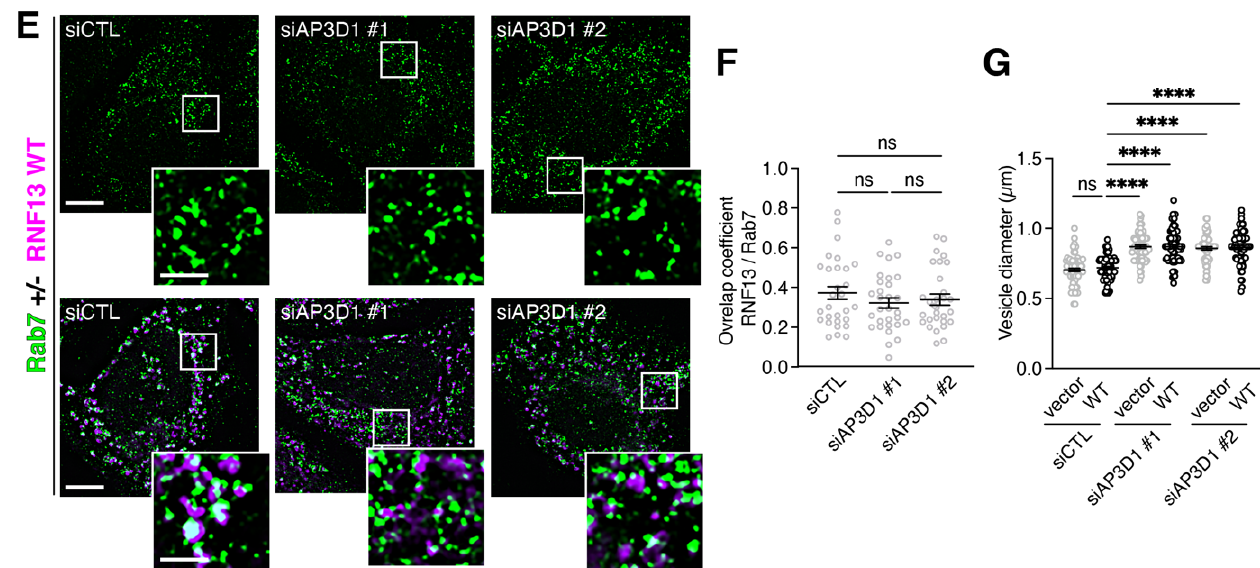
Figure 6. Knockdown of AP-3 interferes with RNF13 localization to lysosomes. ( A ) HeLa cells were transfected using 10 nM of Dicer-substrate siRNAs (DsiRNAs) specific against AP3D1 or nontargeting (siCTL). Three DsiRNAs specific against AP3D1 were tested. Seventy-two hours after transfection, cells were lysed and diluted in Laemmli buffer. Proteins were separated on SDS–PAGE and transferred to a PVDF membrane which was immunoblotted using specific primary antibody against AP3D1. Band densities were analyzed and normalized to the band density of the siCTL lane using ImageLab software. The bar graph presents the mean ± SEM while the strip plot represents the averaged relative protein abundance of each independent experiment analyzed (N = 3). Not significant (ns) or * p < 0.05 using one-way ANOVA with the Kruskal–Wallis test. ( B – G ) HeLa were transfected using 10 nM of DsiRNAs #1, #2 or siCTL for 72 h. Twenty-four hours prior to fixation, cells were transfected with either a plasmid construct encoding HA-tagged RNF13WT or an empty vector. Cells were fixed, permeabilized, and labeled with specific primary antibody against HA (RNF13) and against the endogenous subcellular markers. Representative images from three independent experiments (N = 3) show RNF13-HA (in purple) and ( B ) lysosome marker Lamp1 and ( E ) late endosome marker Rab7 (in green). Scale bars indicate 10 µm for whole-cell image and 2 µm for the boxed area shown at higher magnification. The jittered individual value plots ( C , F ) represent the Manders coefficient of RNF13 over ( C ) Lamp1 or ( F ) Rab7. For each condition analyzed: N = 3, n = 30 cells. Values are expressed as mean ± SEM. Not significant (ns), *** p = 0.0001 or **** p < 0.0001 using one-way ANOVA with the Kruskal–Wallis test. The jittered individual value plots ( D,G ) represent the diameter of the five largest vesicles for each cell. For each condition analyzed: N = 3, n = 15 cells, 75 vesicles. Values are expressed as mean ± SEM. Not significant (ns) or **** p < 0.0001 using one-way ANOVA with the Kruskal–Wallis